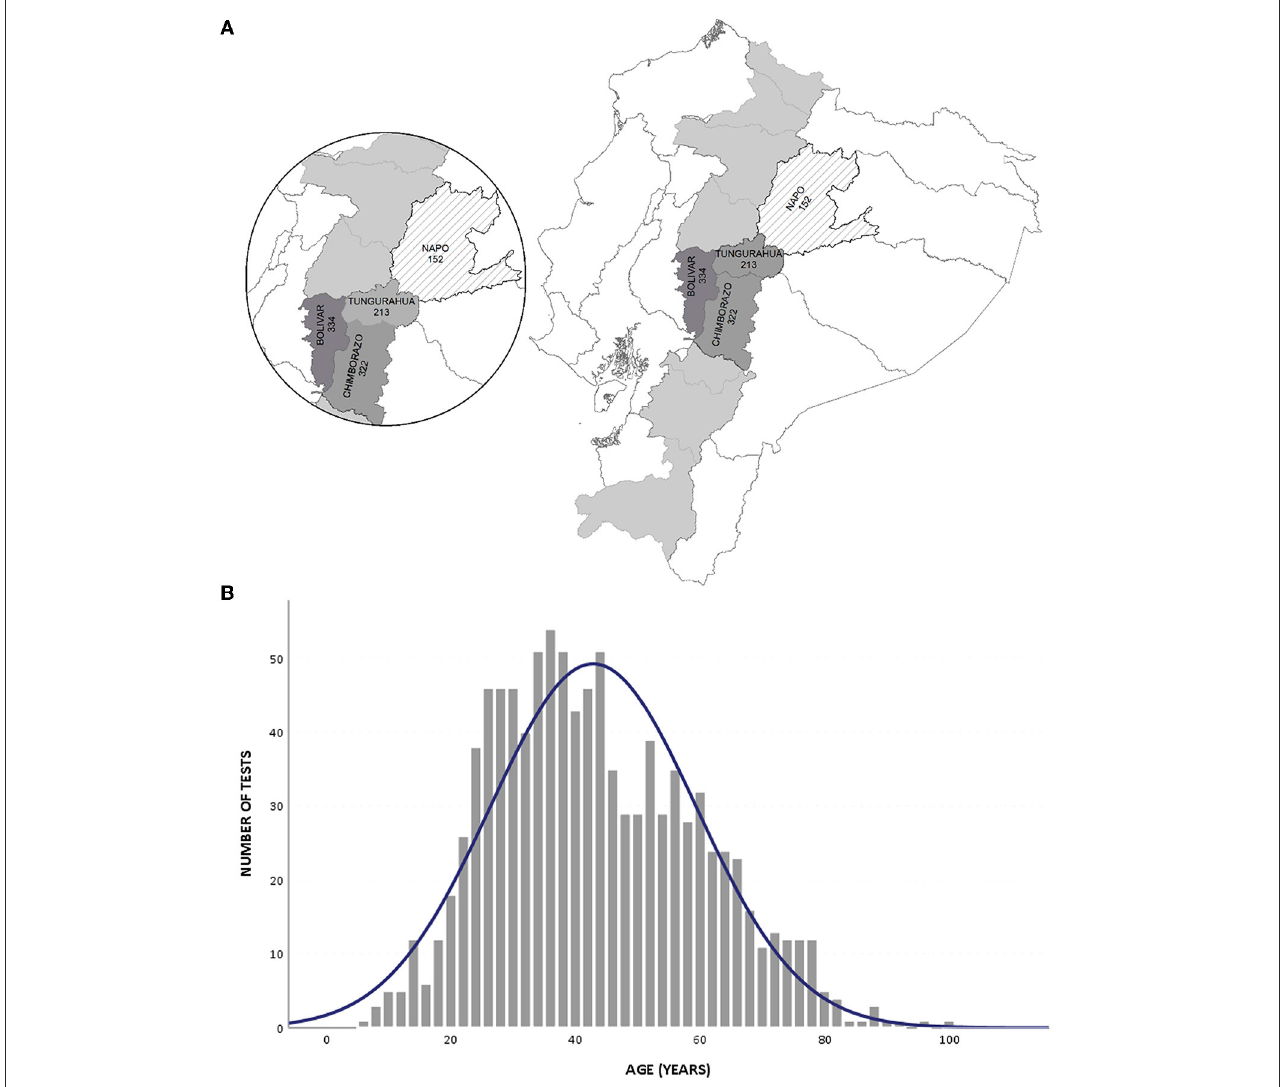
FIGURE1 Study population. (A) Location of the provinces; the gray area indicates the Ecuadorian Andean region. (B) Distribution of tests according to the age of participants.